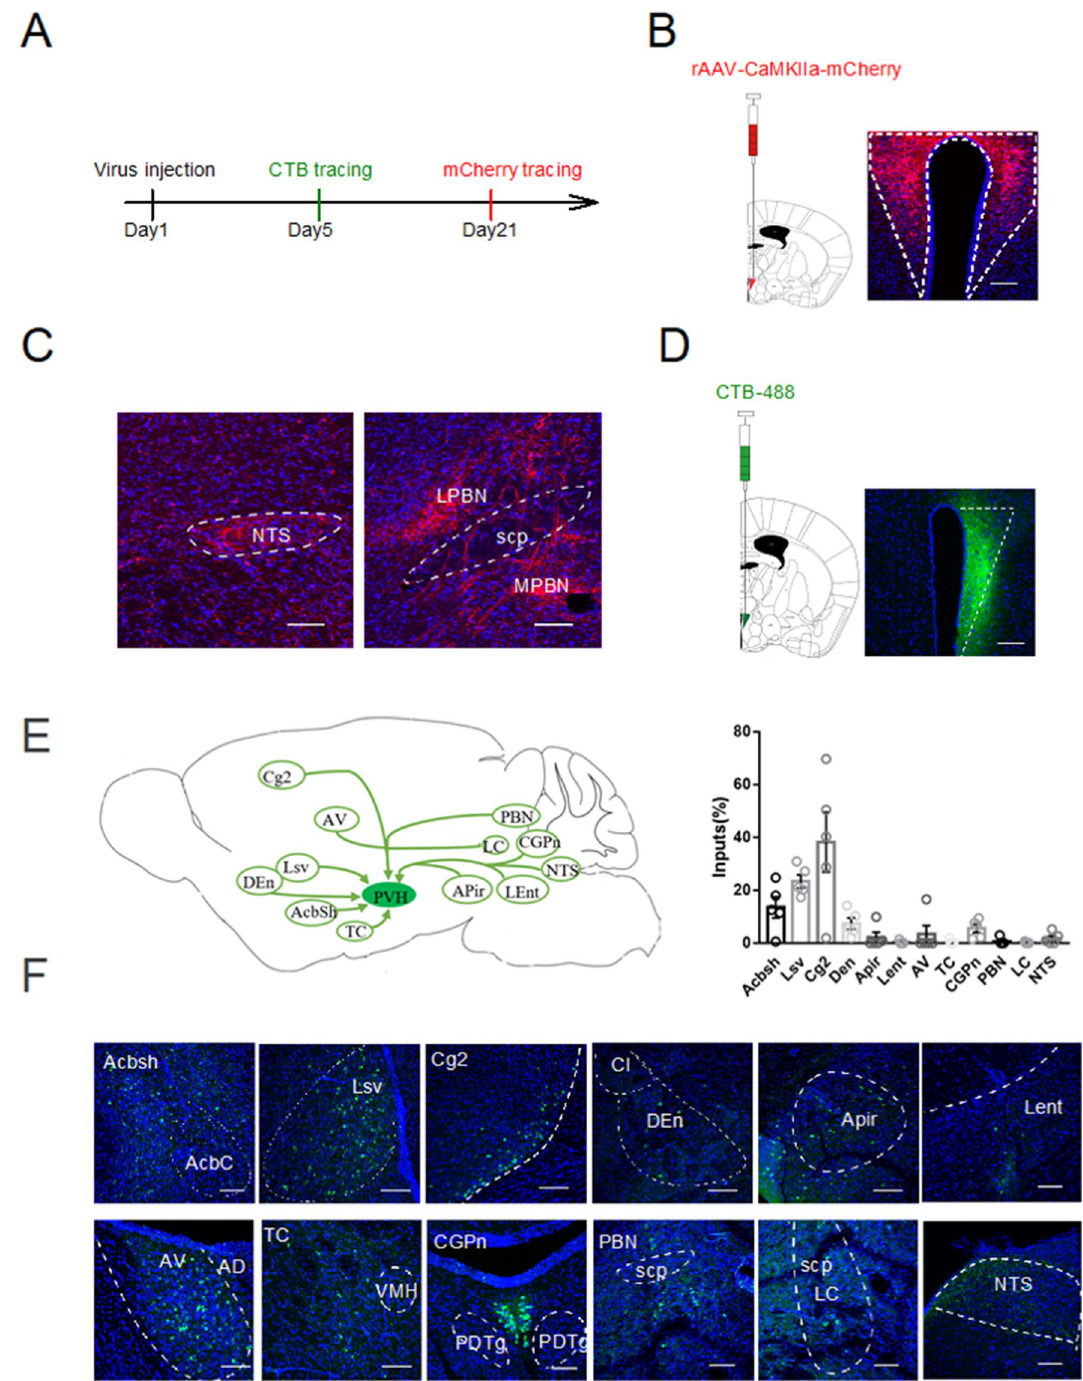
Figure 2. Inputs and outputs of PVH neurons. ( A ) Scheme for specific infection of projection neurons with CTB or mCherry. ( B ) Strategy to anterogradely label the brain regions receiving the projection from PVH by injecting the CaMKIIα-mCherry virus into the PVH ( C ) Confocal images showing mCherry + fibers in NTS (left) and PBN (right) from PVH. Scale bars, 100 μm. ( D ) Left: Strategy to retrogradely label PVH afferents with CTB-488, Right: Confocal images showing CTB injections into PVH. Scale bars, 100 μm ( E ) Left: Cartoon images showing labelled neurons in select upstream regions in the whole brain, right: quantification of monosynaptic inputs in the whole brain, shown as the percent of labelled neurons from a given brain region relative to the total labelled neurons throughout the whole brain, ( F ) Confocal images showing labelled neurons in the selected upstream regions in the whole brain. AcbSh: accumbens nucleus, shell, AcbC: accumbens nucleus, core, aca: anterior commissure, anterior part, Lsv: ventral part of the lateral septal nucleus. Ventral part, Cg2: cingulate cortex, area2, CI: claustrum, DEn: dorsal endpiriform nucleus, APir: amygdalopiriform transition area, Lent: lateral entorhinal cortex, AV: anteroventral thalamic nucleus, AD: anterodorsal thalamic nucleus, TC: tuber cinereum area, VMH: ventromedial hypothalamic nucleus, PDTg: posterodorsal tegmental nucleus, CGPn: central gray of the pons, PBN: parabrachial nucleus, scp: superior cerebellar peduncle, LC: locus coeruleus, NTS: the solitary tract nucleus. Data are shown as mean ± SEM, N = 5 mice. Scale bars, 100